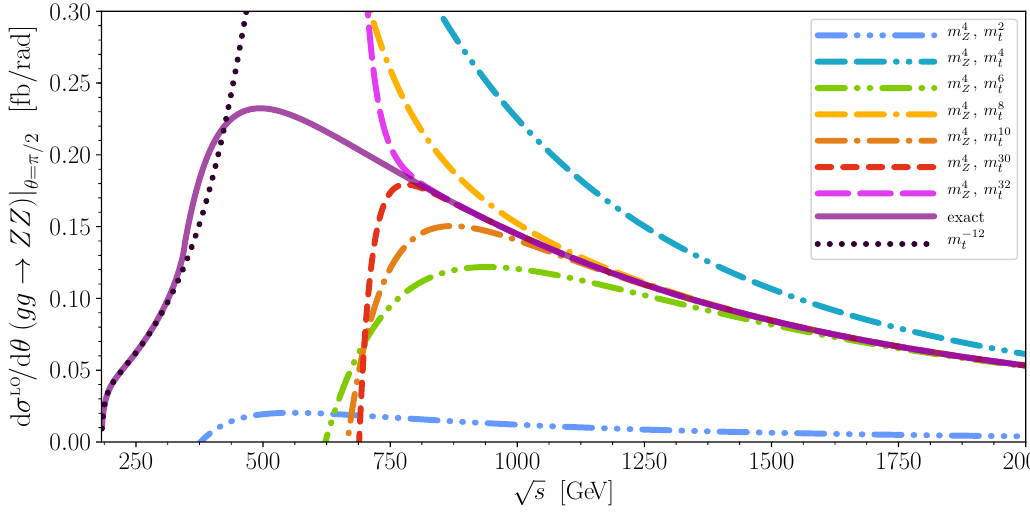
ZZ for (cid:18) = (cid:25)= 2. Solid, dash-dotted and !